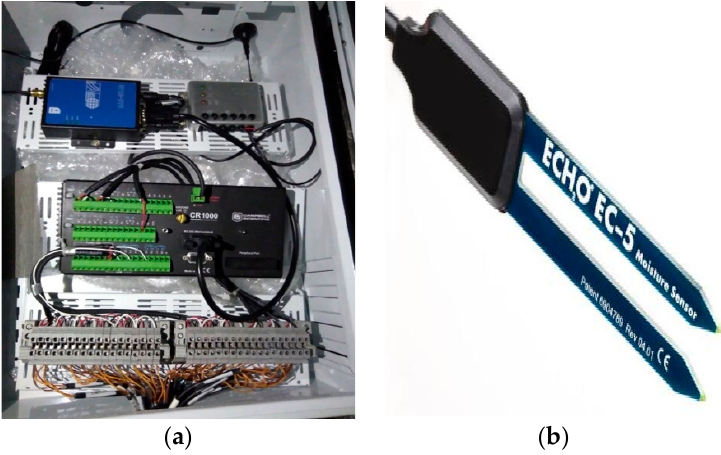
Figure 4. Data acquisition system and measuring sensor: ( a ) Data acquisition equipment; ( b ) volumetric water content sensor.